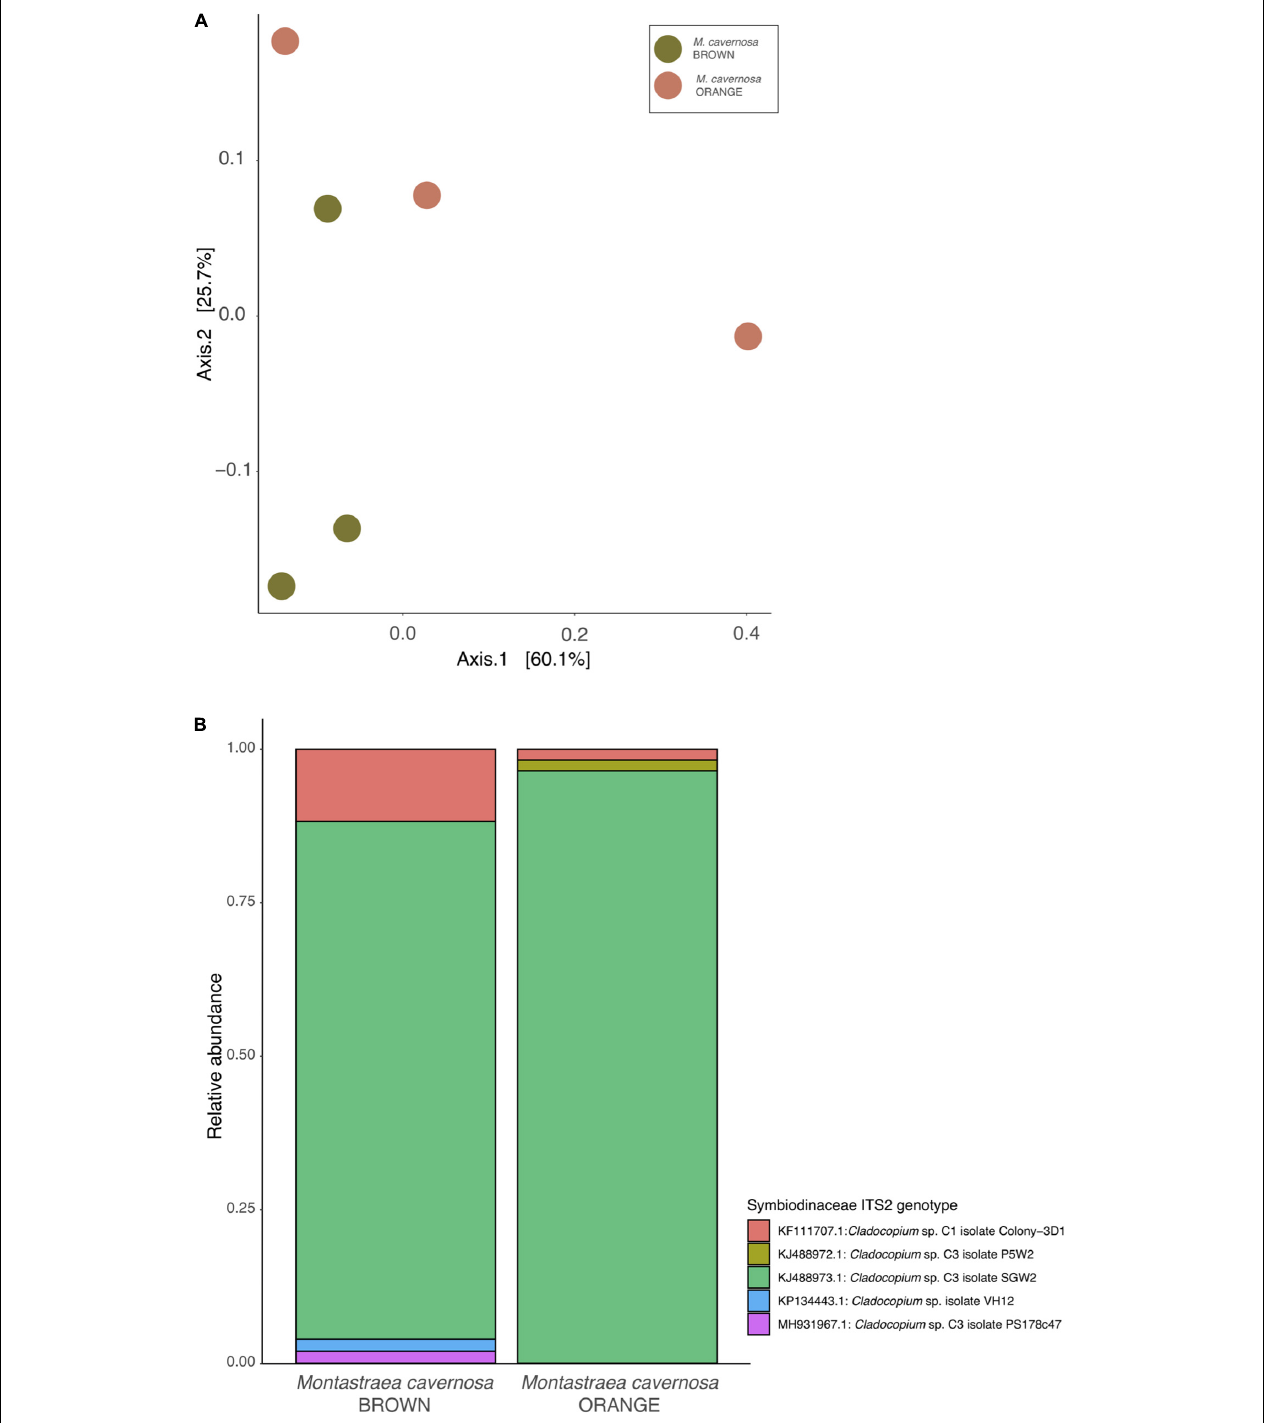
FIGURE 2 | Symbiodiniaceae communities of Montastraea cavernosa color morphs. (A) Non-metric MDS plot of Symbiodiniaceae diversity across treatment group and color morph. (B) Average relative abundances of Symbiodiniaceae OTUs, clustered to 97%. ITS2 variant clusters are colored by closest match in the curated Symbiodiniaceae SymTyper